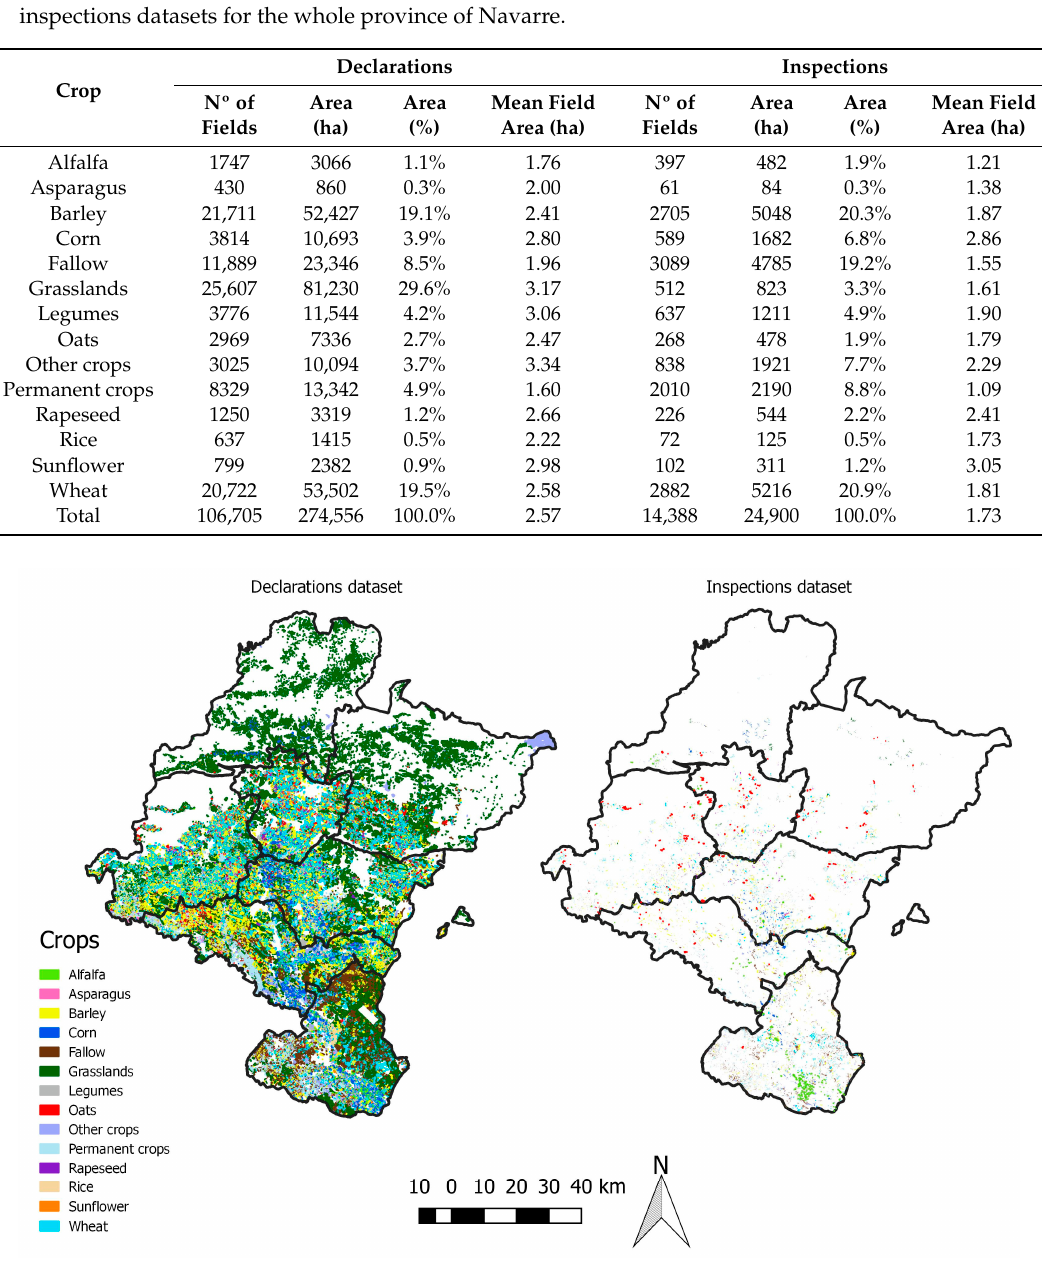
Figure 3. Distribution of ground truth datasets in Navarre: declarations dataset ( left ) with 106,705 fields, and inspections dataset ( right ) with 14,388 fields.